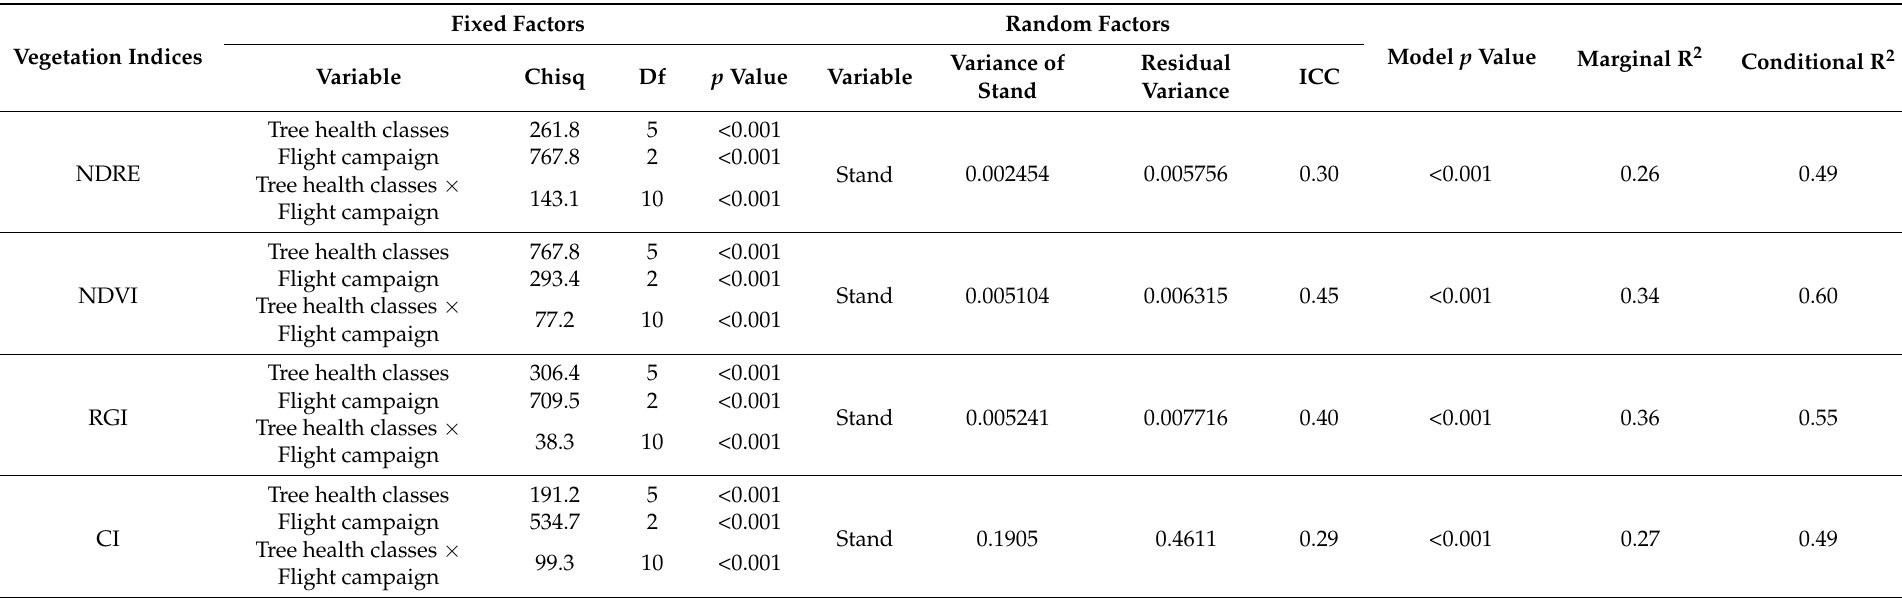
Table 4. Summary of results of LMER